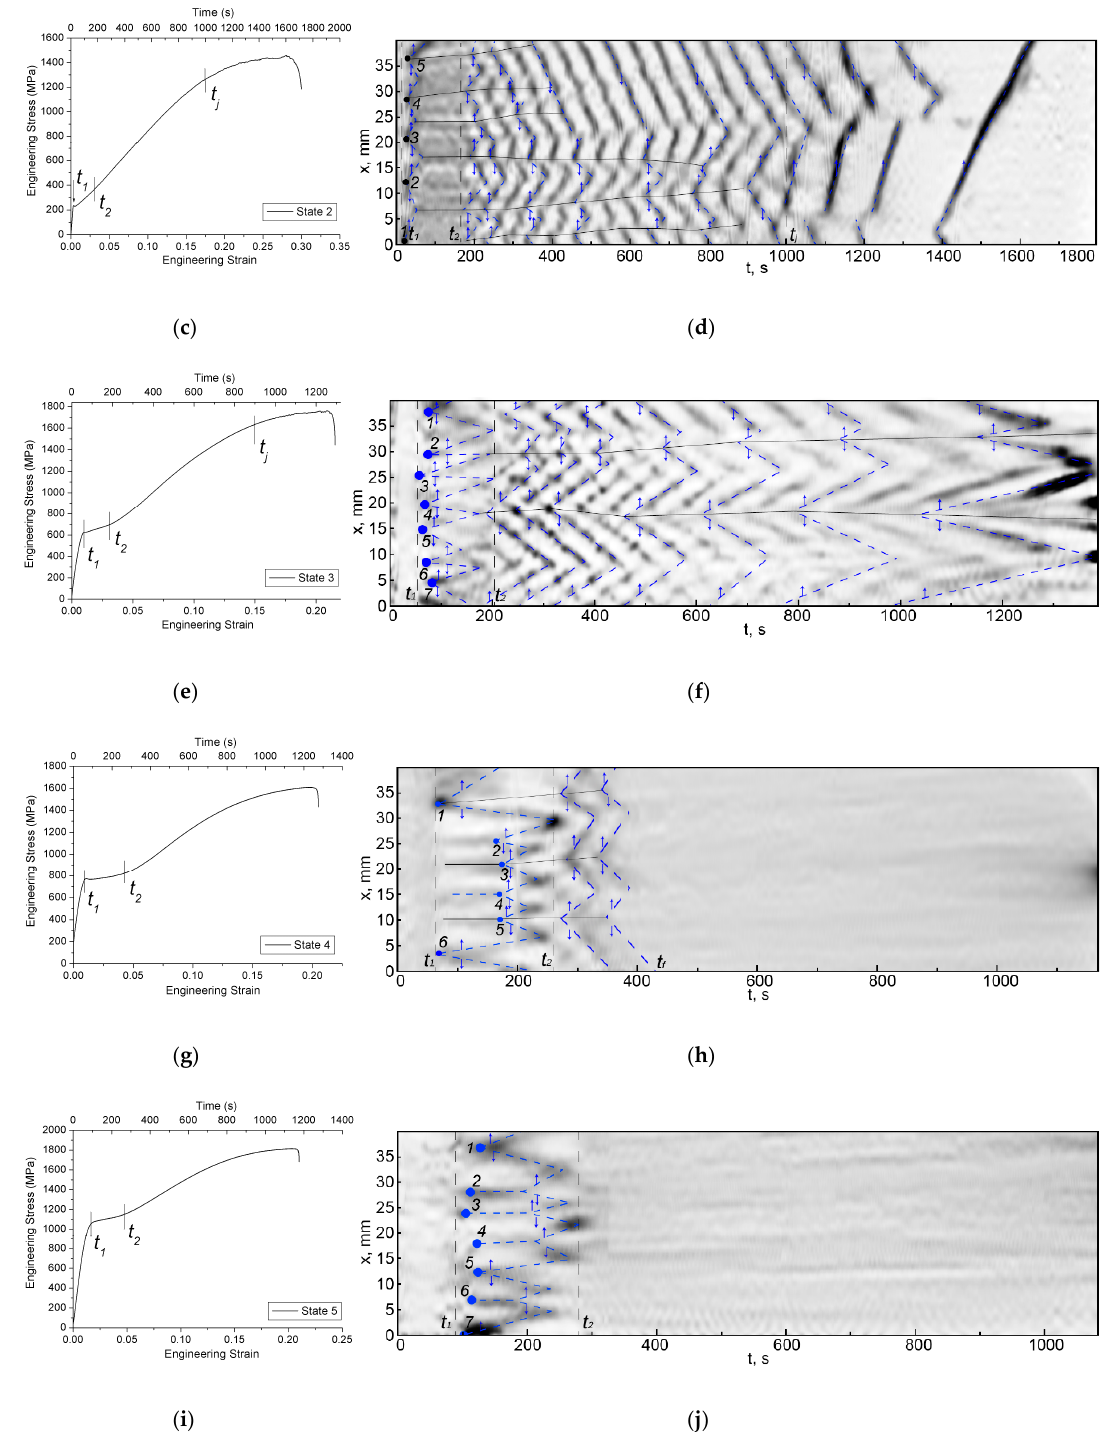
Figure 3. Loading curves of TRIP steel and the chronogram of the propagation of phase transformation fronts: ( a , b ) annealing at 600 °C (state 1 ); ( c , d ) after austenitization (state 2 ); ( e , f ) after austenitization and warm rolling to 40% reduction (state 3 ); ( g , h ) after austenitization and warm rolling to 51% reduction (state 4 ); ( i , j ) after austenitization and warm rolling to 63% reduction (state 5 ). The arrows indicate the front propagation direction, points 1 – 7 denote the nucleation sites of primary localization bands.